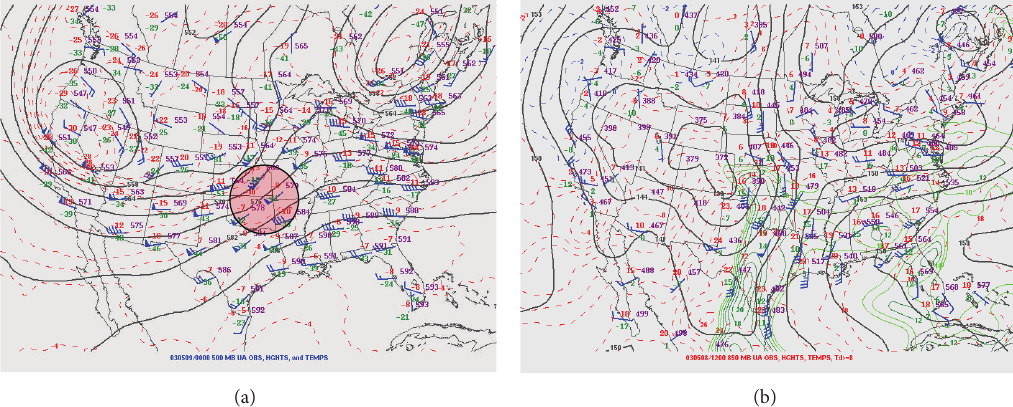
Figure 2: (a) 500mb analysis and upper air observations, (b) 850 mb analysis and upper air observations valid at 0000 UTC, 9 May 2003. The red-shaded circle denotes the position of a short-wave trough. Heights are shown as black contours (in decameters), temperature is shown by dashed red contours, and dewpoint temperatures greater than 8 degrees celsius are contoured in green. Note also the 850 mb 50 knot wind observation at Dallas/Fort Worth (image from